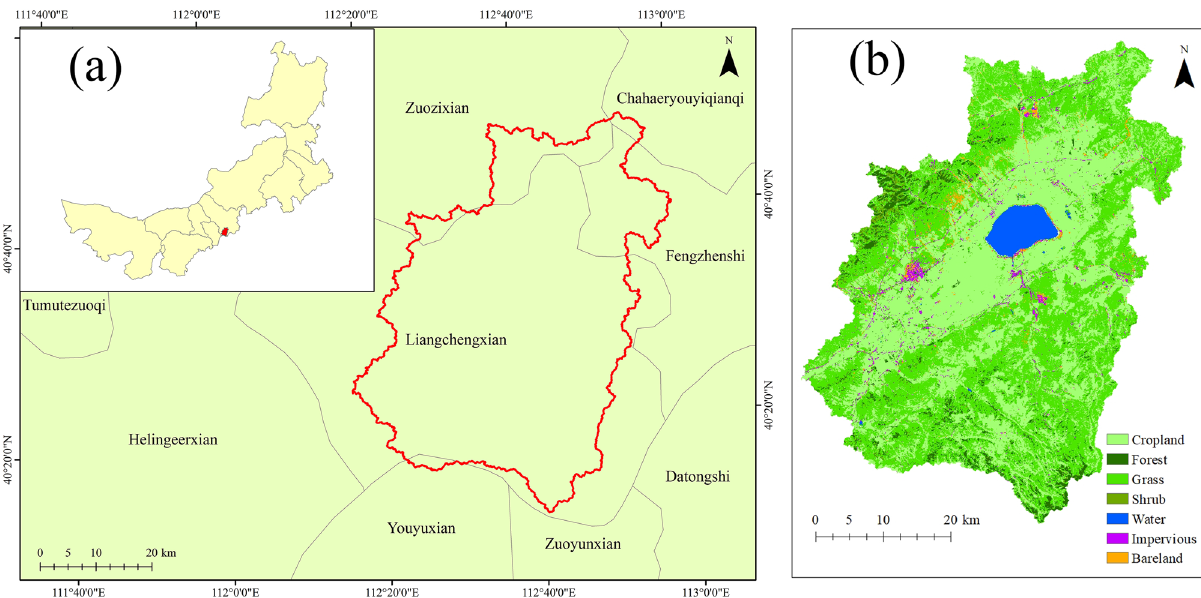
Figure 1. Overview of the study area: ( a ) Geographical location of the Daihai Basin; ( b ) Land Use in the Daihai